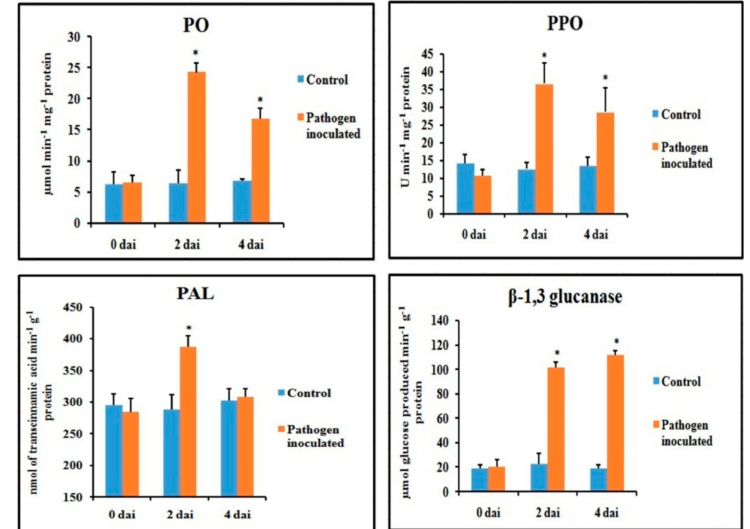
Figure 4. E ff ect of C. gloeosporioides on on the production of defense enzymes in detached bean leaf. Values represent mean ± SD of three separate experiments, each in triplicate. * Significant di ff erence between pathogen-inoculated and control sets at P < 0.05